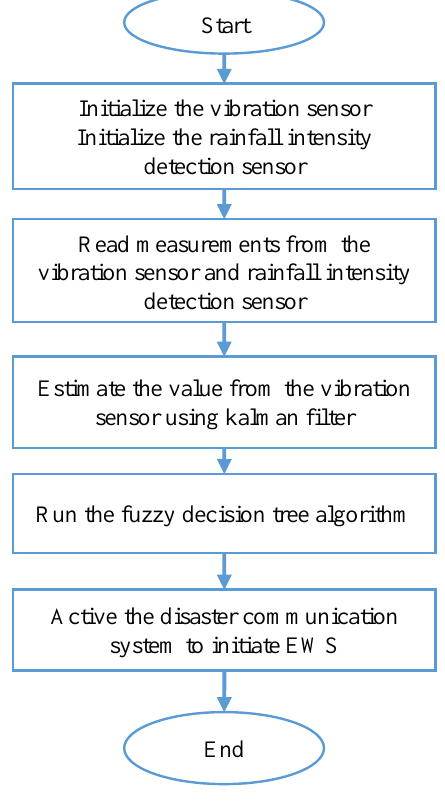
Figure 1. Flow chart of lava flood detection